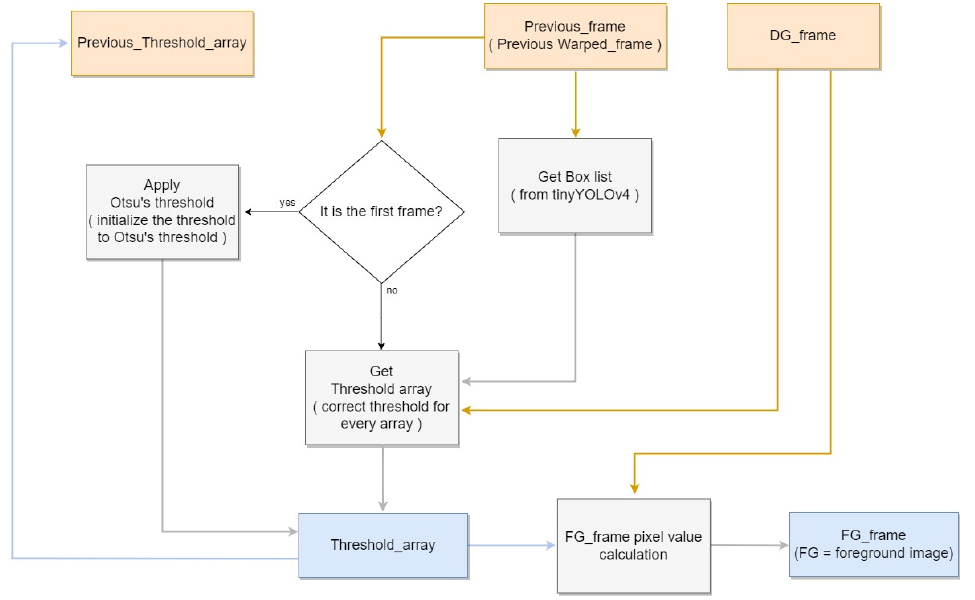
Figure 7. Non-Pig Pixel Suppression block diagram.